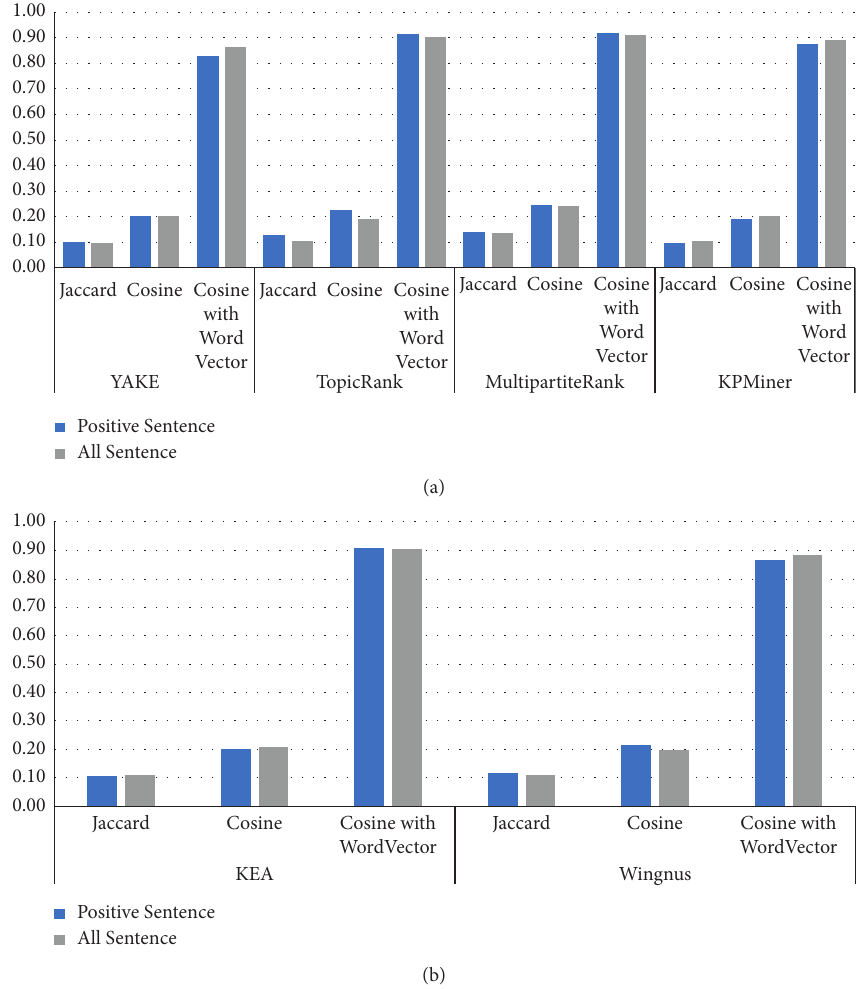
Figure 3: Distribution of similarity scores of supervised and unsupervised keyword extraction techniques employed in positive and all sentences for Jaccard, cosine, and cosine with Word vector similarity indexes. (a) Similarity score distribution of positive and all sentences for unsupervised YAKE, TopicRank, MultipartiteRank and KPMiner keyword extraction algorithms for all the similarity indexes. (b) Similarity score distribution of positive and all sentences for supervised KEA and Wingnus keyword extraction algorithms for all the similarity